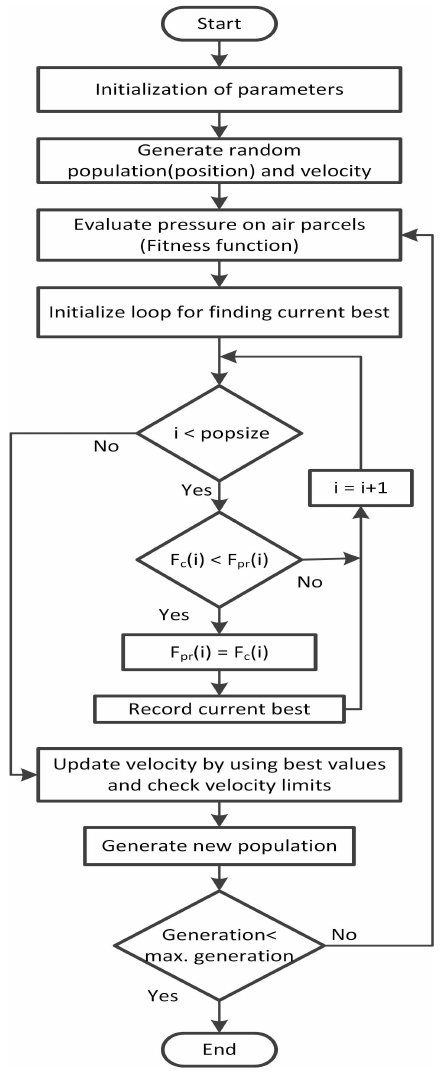
Figure 7. Flow chart of